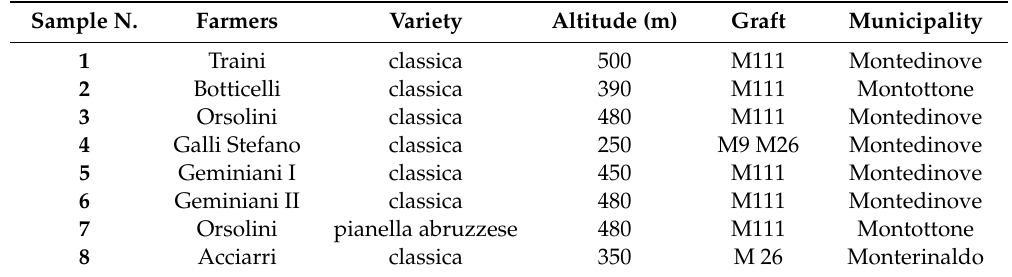
Table 5. Main information on the apple samples of Mela Rosa dei Monti Sibillini. Sample